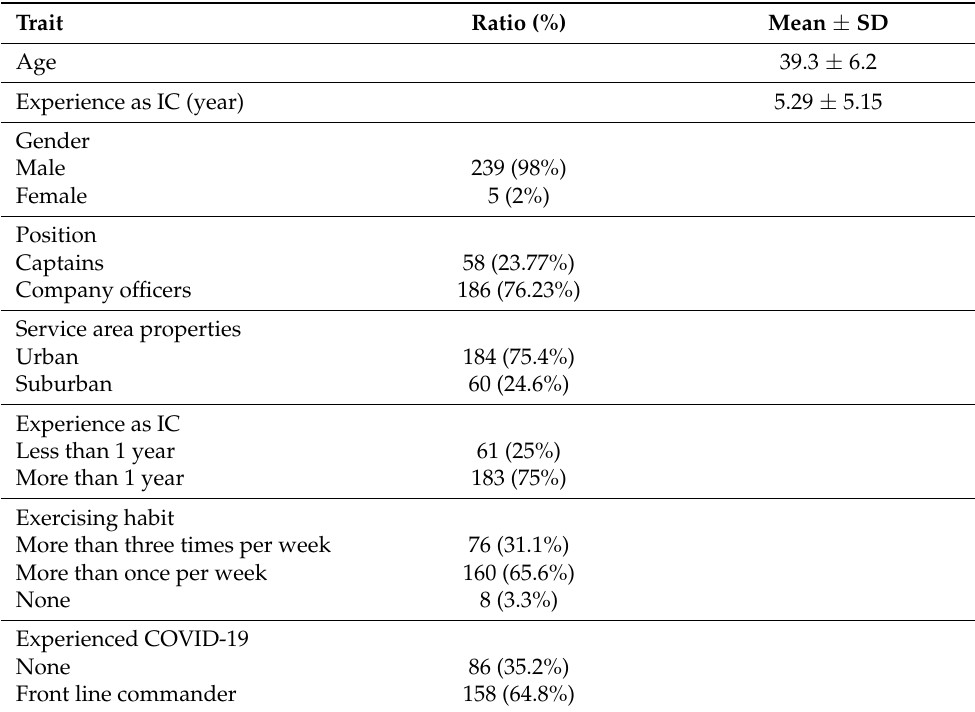
Table 1. Distributions of trainees’ characteristics and composition ratios ( n = 244).